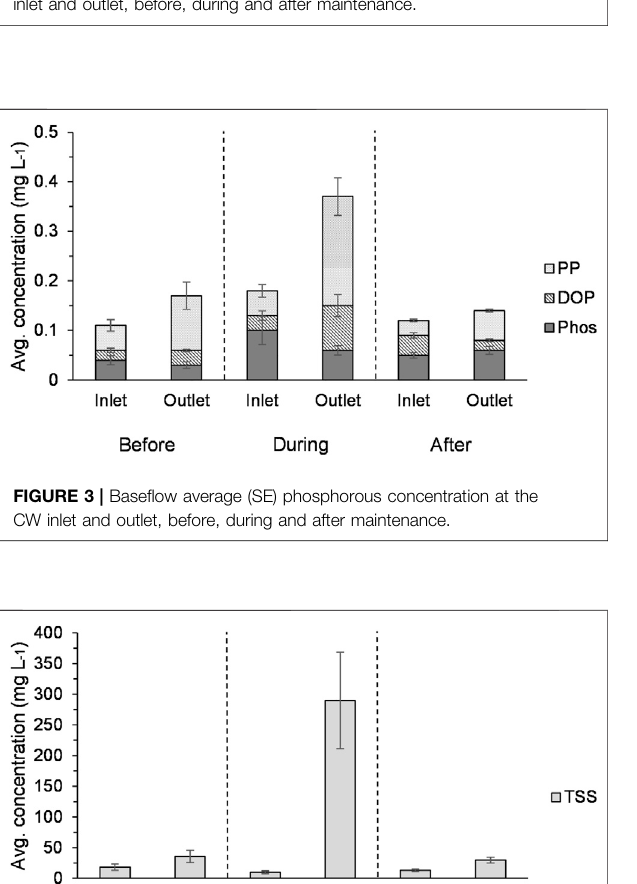
Frontiers in Environmental Chemistry |